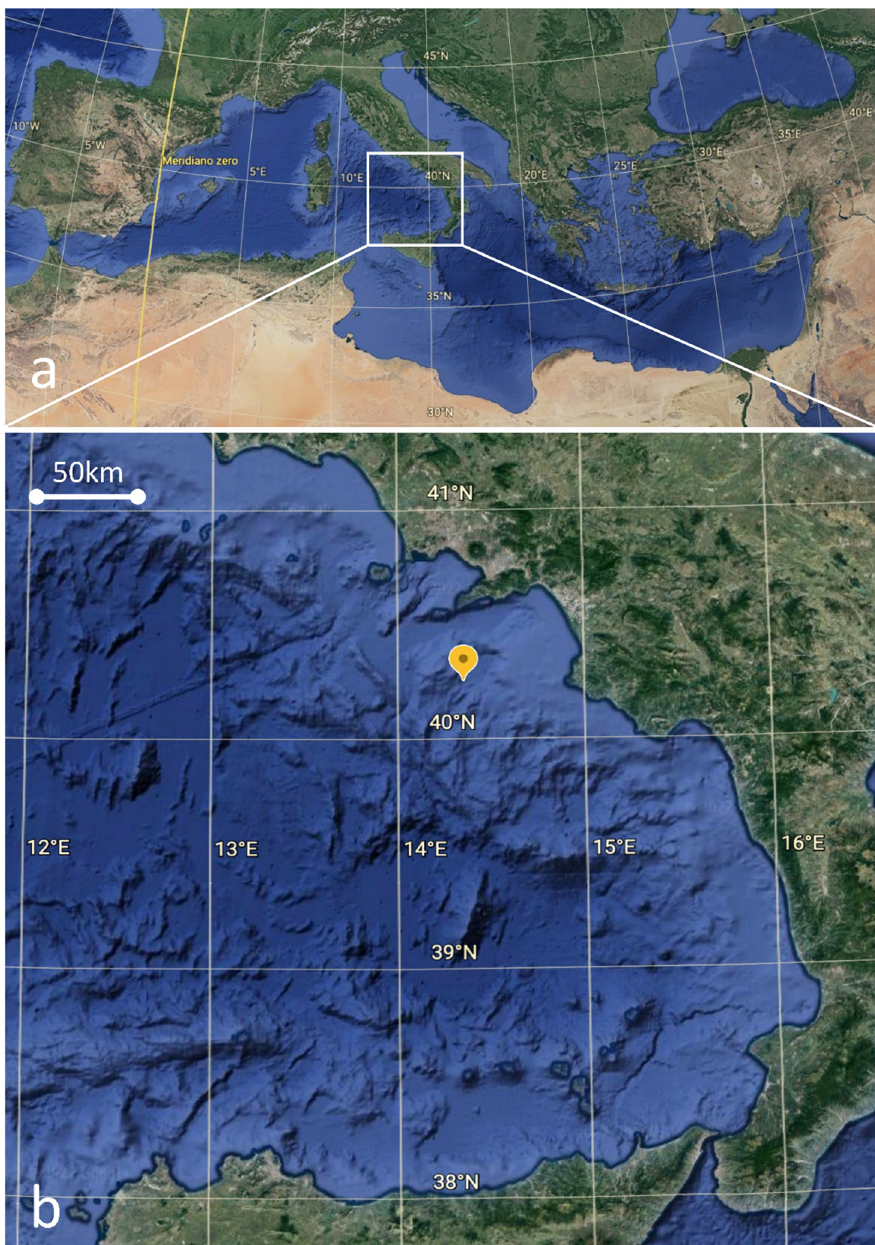
Figure 1. General view of the Mediterranean basin ( a ), with a particular of the studied area (GSA 10) ( b ). The yellow mark indicates the sampling point with coordinates (40°24.087 ″ N 14°35.396 ″ E). Samples collected during autumn 2021 at 316 m of depth were frozen on board to preserve the integrity of biological tissues and were immediately transferred to the laboratory after landing. During the gross necropsy performed in laboratory, each specimen was measured (total length in mm) weighted (weight in g) and sex maturation degree was determined according to Follesa, and Carbonara [57]. Concerning the hermaphrodite specimen, the maturation degree of both expressed sexes was evaluated. Measurements of the reproductive system were also performed: the Inner clasper length (i.e., distance in mm between the distal clasper tip to the insertion point at the cloaca), the Outer clasper length (distance in mm between the clasper tip and the outside insertion point in the pelvic fin), the Uteri (left and right) length (mm), maximum oviducal gland (left and right) diameter (mm) and weight (g), length (mm), width (mm) and weight (g) of ovaries and